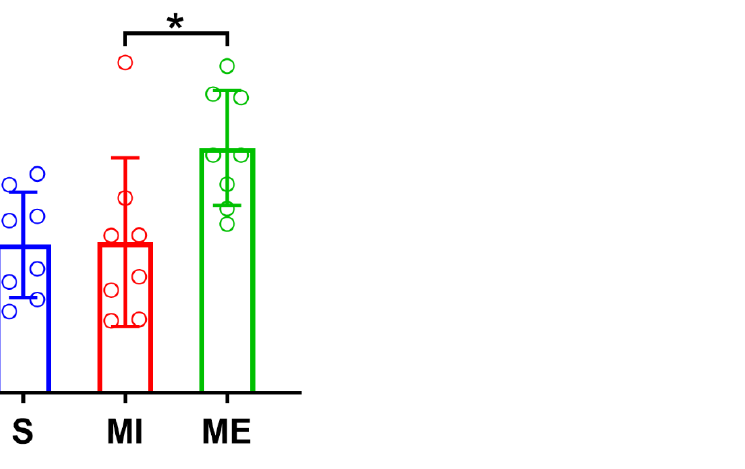
Figure 5. Quantified levels of CHI3L1 from rat serum samples ( n = 8/group) assessed by ELISA. Abbreviations : S, sham control group; MI, myocardial infarction group; ME, post-MI exercise trained group. Symbol * indicates p < 0.05 when comparing groups MI and ME.